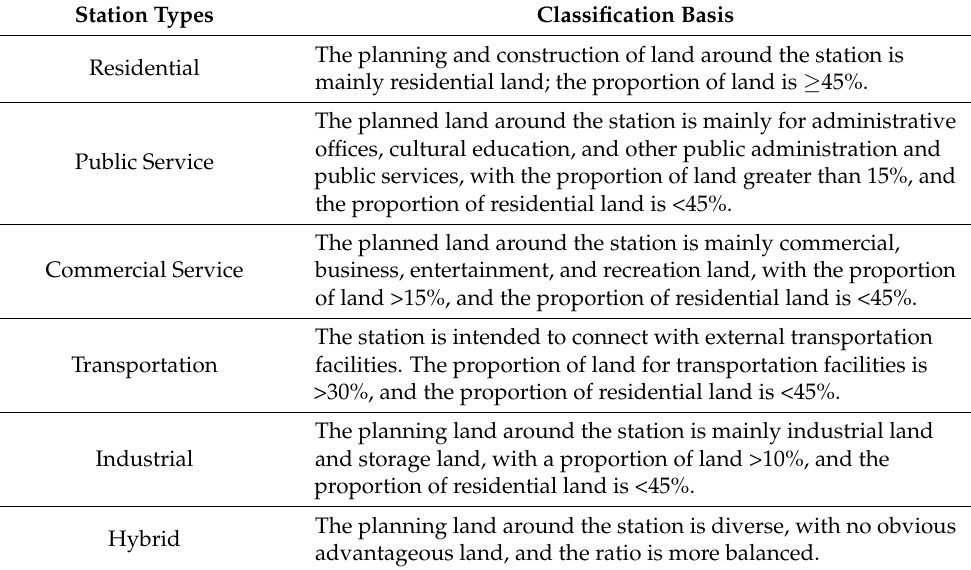
Table 1. Classification basis of rail transit stations.